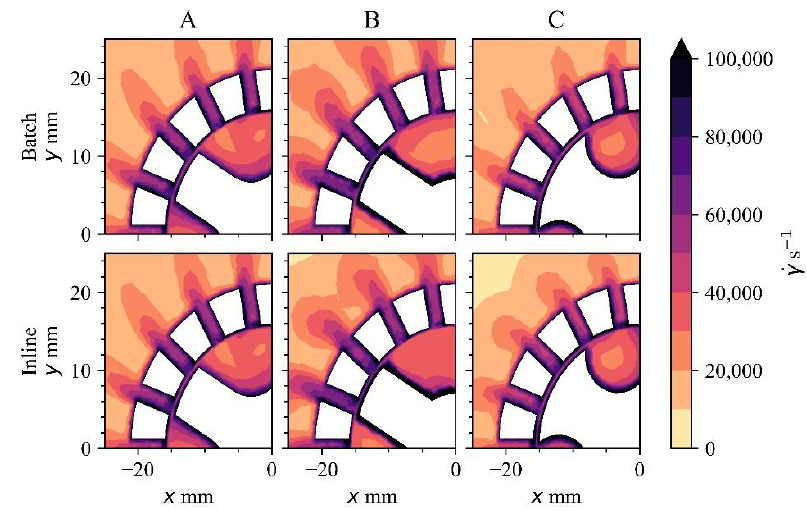
Figure 7. Quarter plot of the shear rate contours along the plane z = 13 mm.